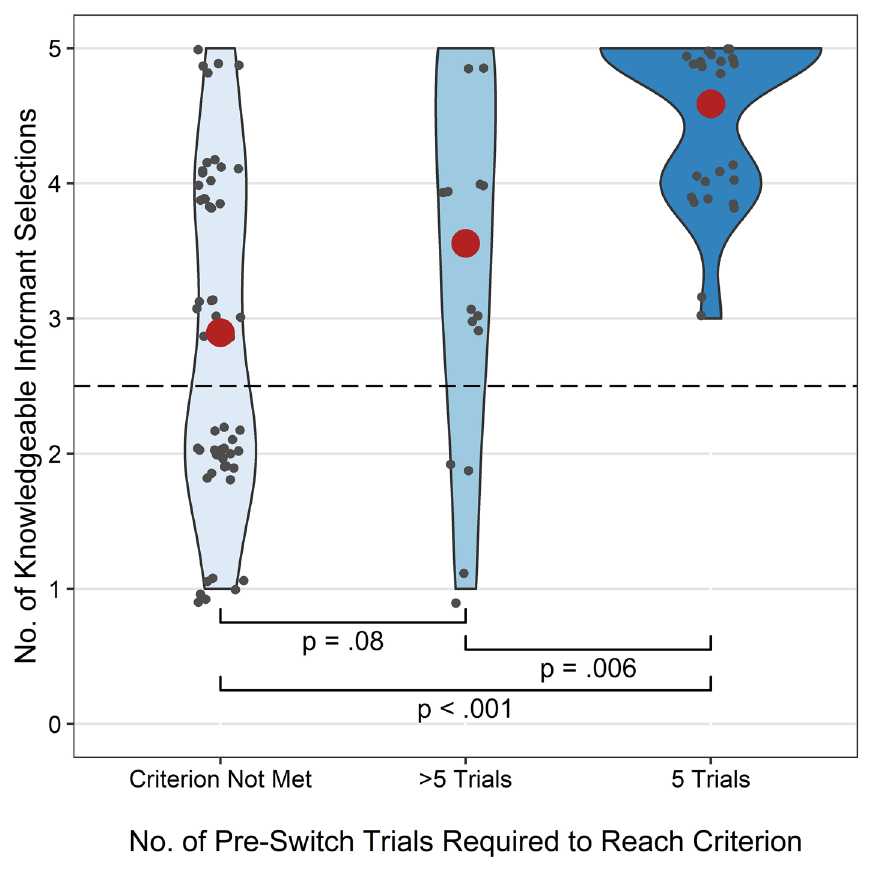
Figure 3. Number of switch trials in which children selected the knowledgeable informant by the number of pre-switch trials required to meet criterion. Children who met criterion after only five trials performed significantly better than children who took more than five trials to reach criterion and children who did not reach criterion. Small black points show individual participants’ performance, large red points indicate group means. Brackets indicate differences between groups. Dashed line indicates chance